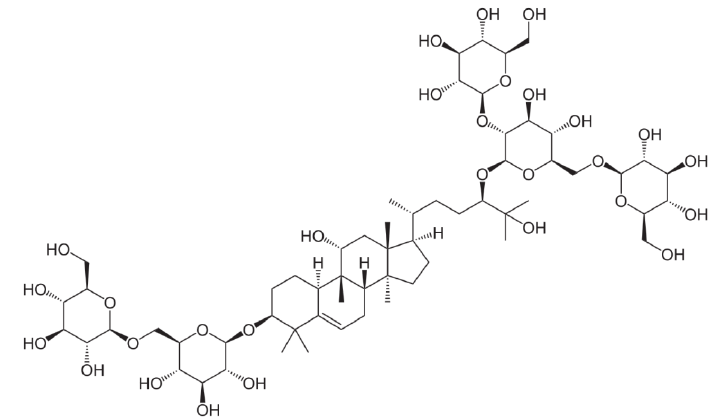
Fig. 7: Chemical structure of mogroside